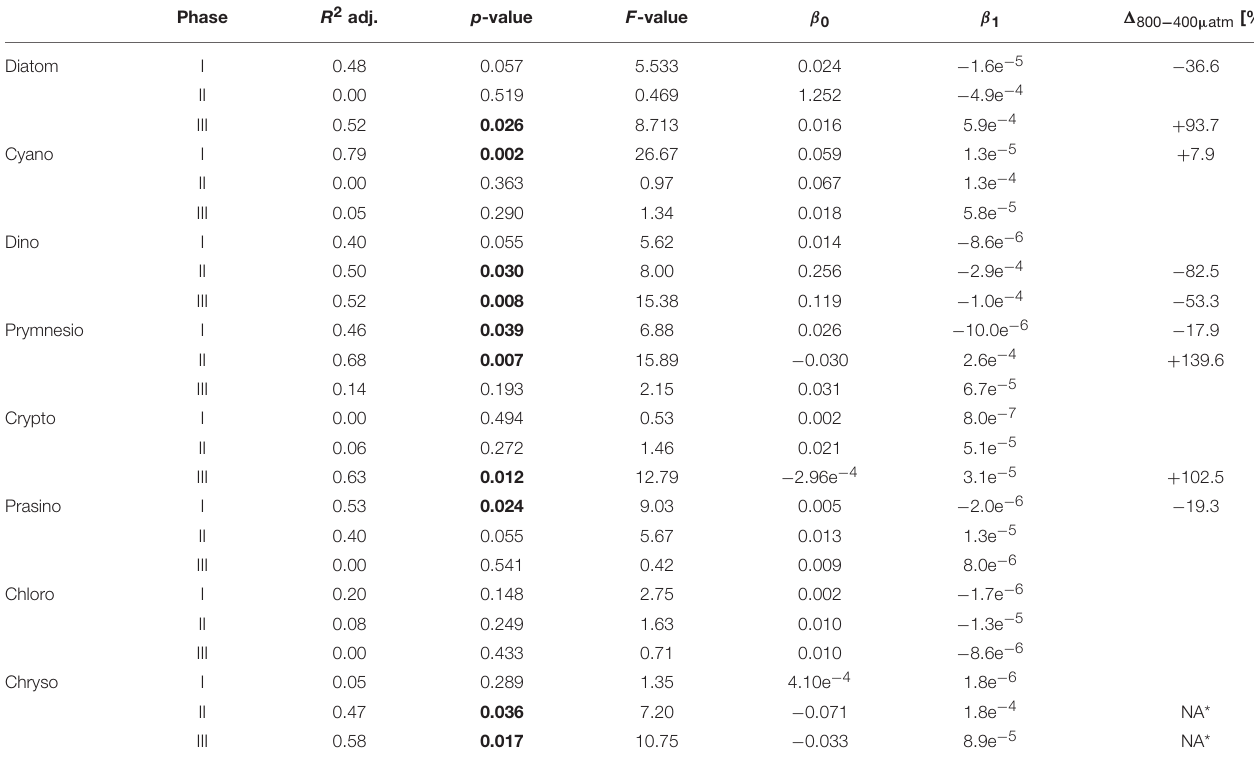
TABLE 3 | Results of linear regression for CO 2 effects on phytoplankton groups based on pigment analysis (HPLC) and CHEMTAX. Phase R 2 adj.